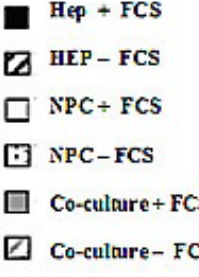
Figure 7. LDH activity of the cells in the sandwich and spheroid culture. (A): LDH activity of the cells in the sandwich culture per 10 million from day 1 to day 5. (B): LDH activity of the cells in the spheroid culture per 10 million cells, day 1 to day 5. Each point represents the mean ± S.E.M. of five experiments during which LDH activities were measured in